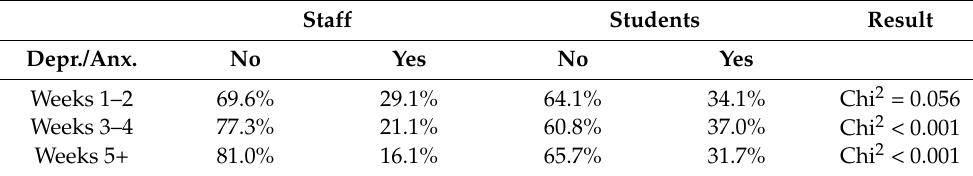
Table 3. Depression and